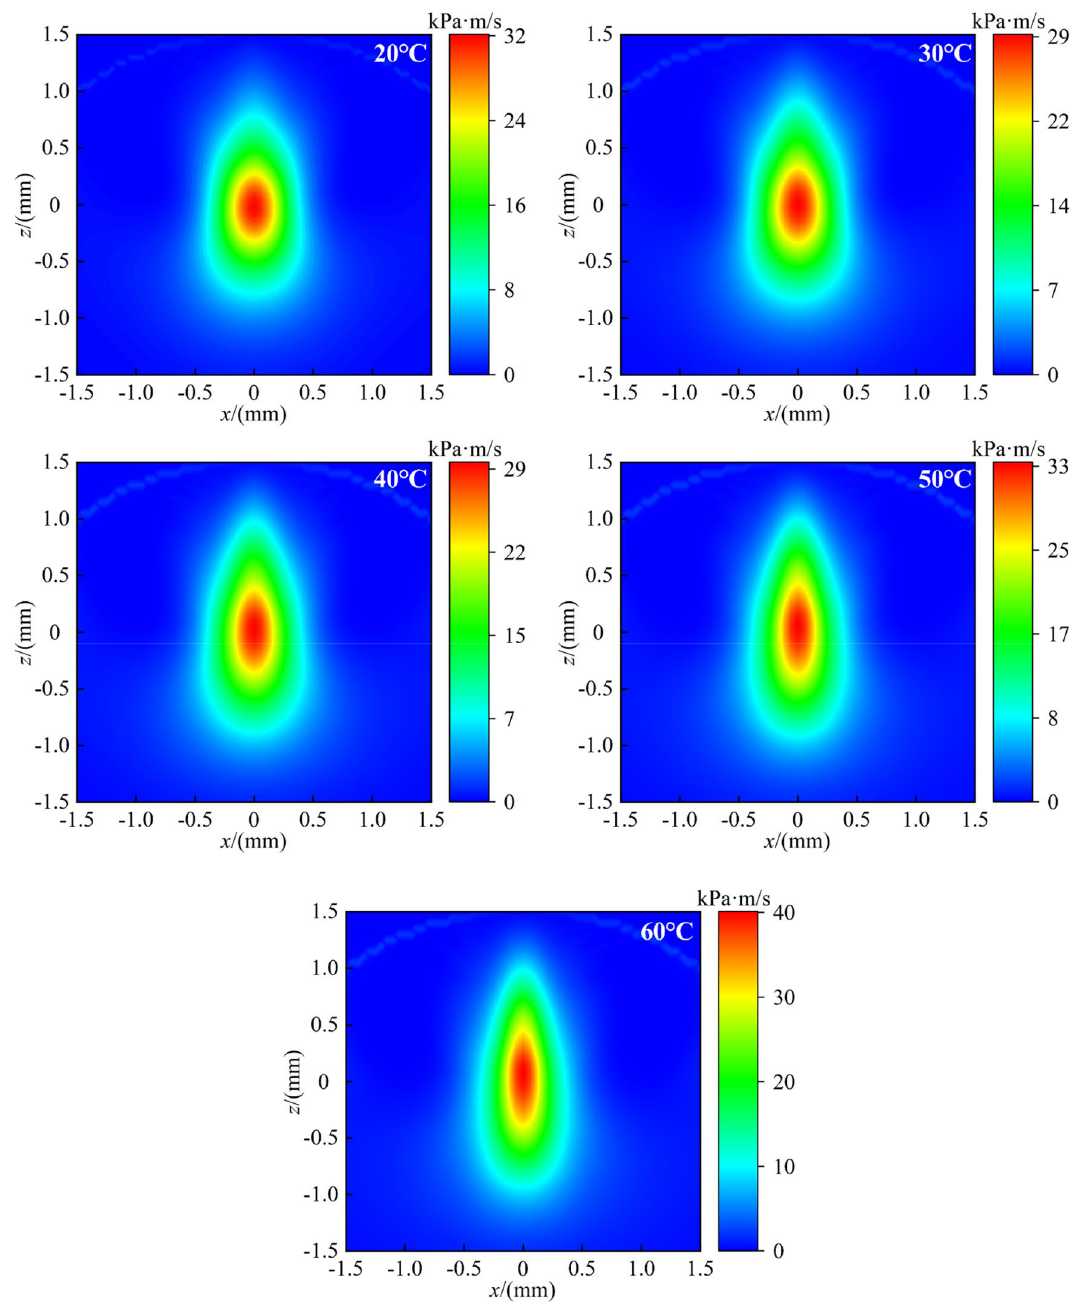
Figure 8. Product distribution zone of relative velocity and shear